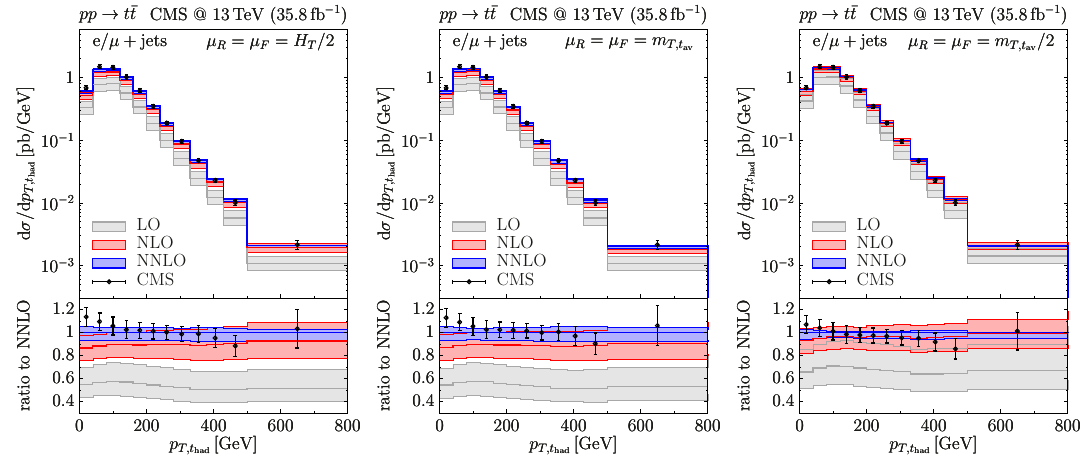
Figure 3 . Single-di(cid:11)erential cross sections as a function of p T;t . CMS data [9] and LO, NLO had and NNLO results for central scales equal to H T = 2 (left), m T;t (central) and m T;t = 2 (right). av av respectively. The p T;t distribution has a maximum at p T;t 80 GeV. The LO and had had (cid:24) NLO scale-uncertainty bands do not overlap, except for (cid:22) 0 = m T;t = 2. This is consistent av with what happens for the corresponding total cross sections. The NLO and NNLO bands do overlap in the entire p T;t range, suggesting a good convergence of the had